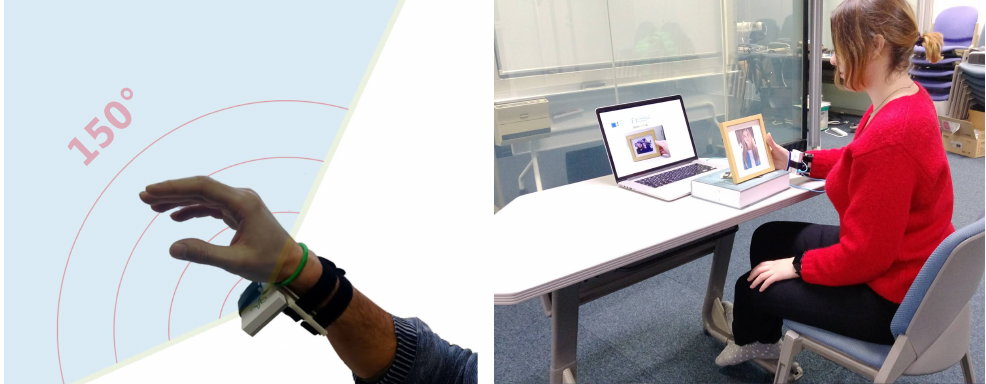
Figure 7. ( Left ): We used a wrist-mounted Google Soli for sensing micro-gestures on physical objects; ( Right ): In our recording session, participants sat at a desk while interacting with a standing wooden photo